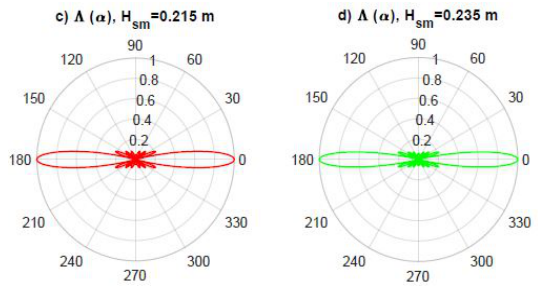
Figure 4. Polar plots of the beam patterns of the silo music phenomenon for a) H sm = 0.215 m and b) H sm = 0.235